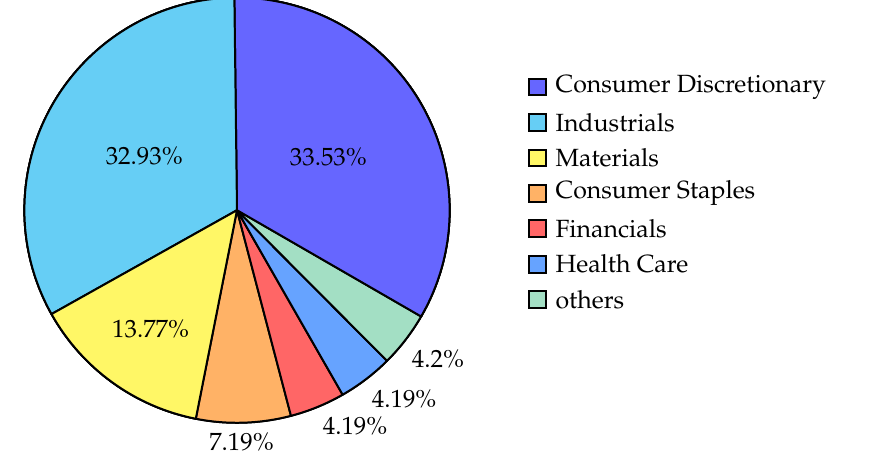
Figure 9. Distribution of papers by sector.